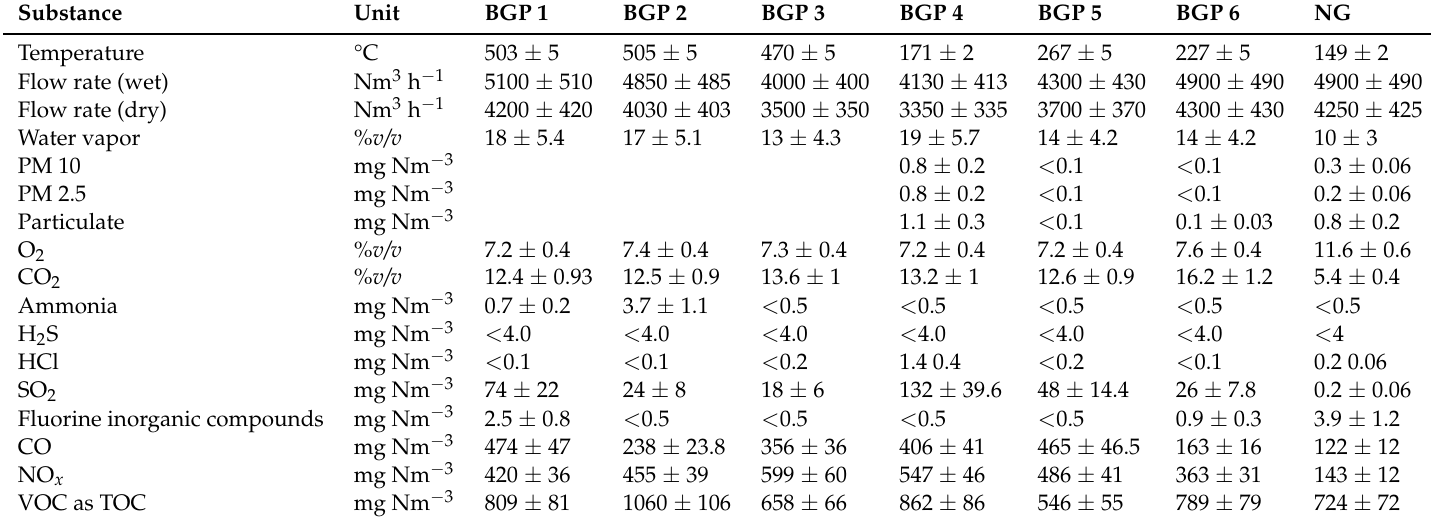
Table 15. Exhaust gases physical and chemical characteristics. PM10, PM2.5 and particulate can not be measured with adopted equipment when exhaust gases temperature is higher than 300